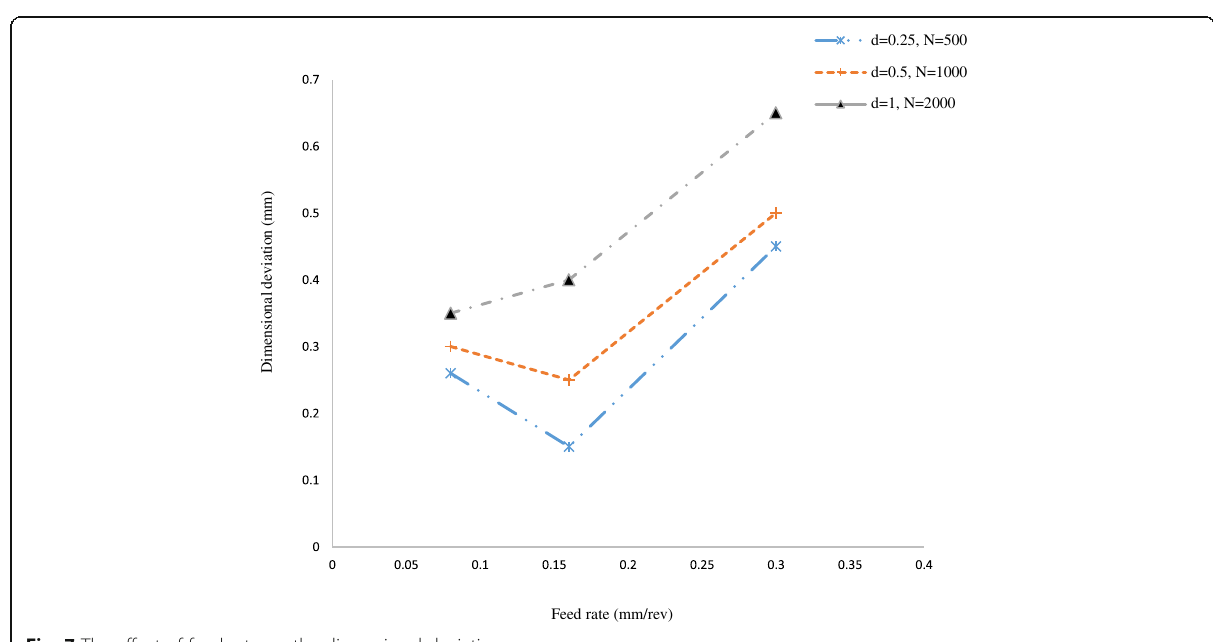
Fig. 7 The effect of feed rate on the dimensional deviation